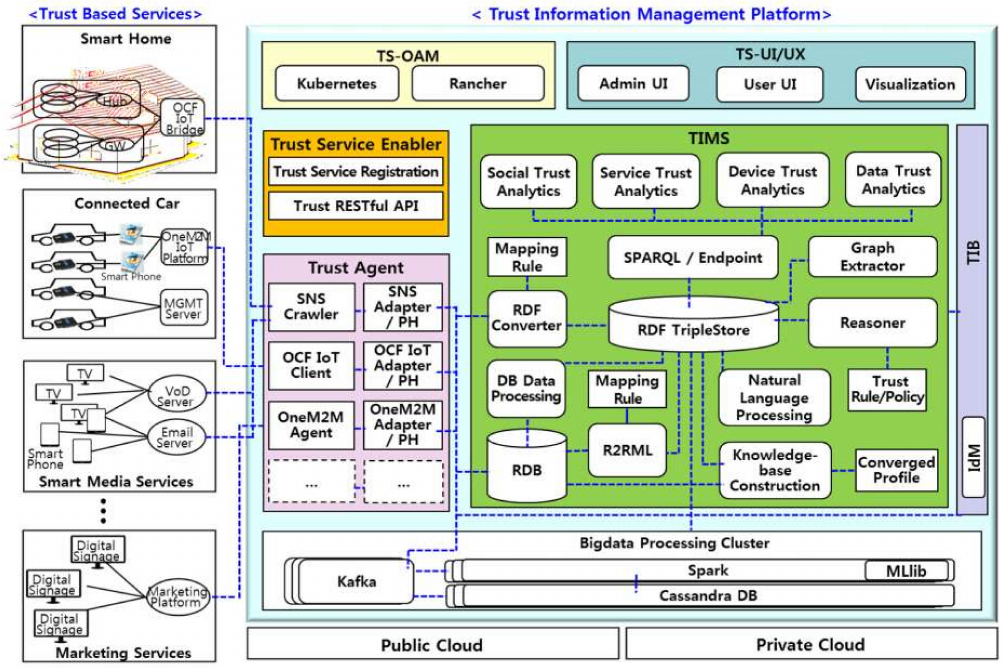
Figure 4. Architecture of the trust information management